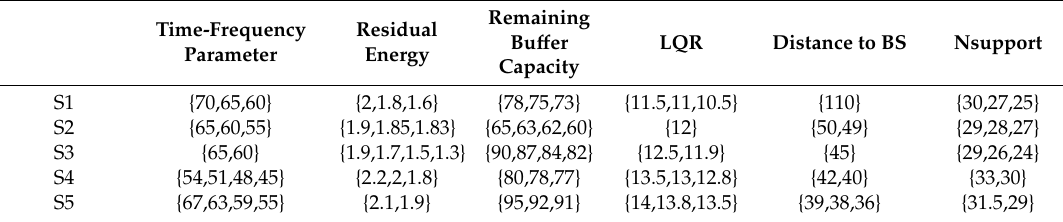
Table 3. Measured value after screening matrix.